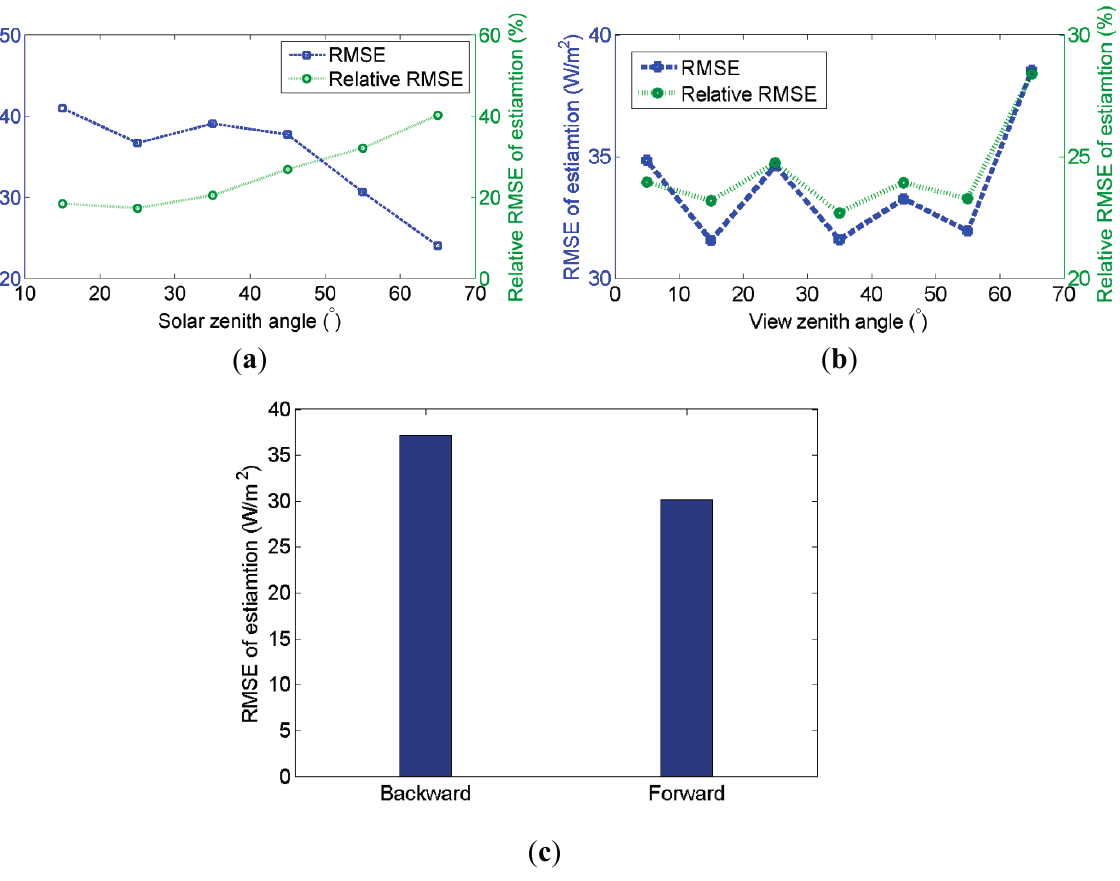
Figure 5. Dependency of retrieval accuracy of daily SSNR on view geometry: ( a ) solar zenith angle, ( b ) view zenith angle and ( c ) relative azimuth angle (backward and forward